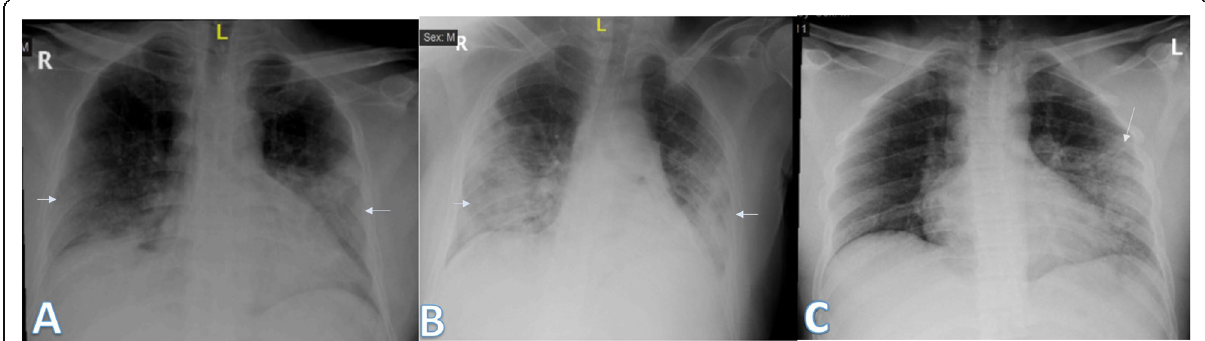
Fig. 5 Three different patients with positive COVID-19. a 29-year male was complaining of SOB, fever, and cough. Initial chest X-ray shows bilateral lower zonal air space consolidation opacities (arrows). The severity score was 2 for each lung, so TSS was 4. b 52-year male was complaining of dyspnea and fever. Initial chest X-ray shows bilateral air space consolidation opacities (arrows) at both mid and lower lung zones (with lower zonal predominance). The severity score was 3 for each lung, so TSS was 6. c 32-year male patient was complaining of SOB and cough. Initial chest X-ray shows air space consolidation opacity (arrow) at the left mid and lower lung zones (with lower zonal predominance). The total severity score was 3